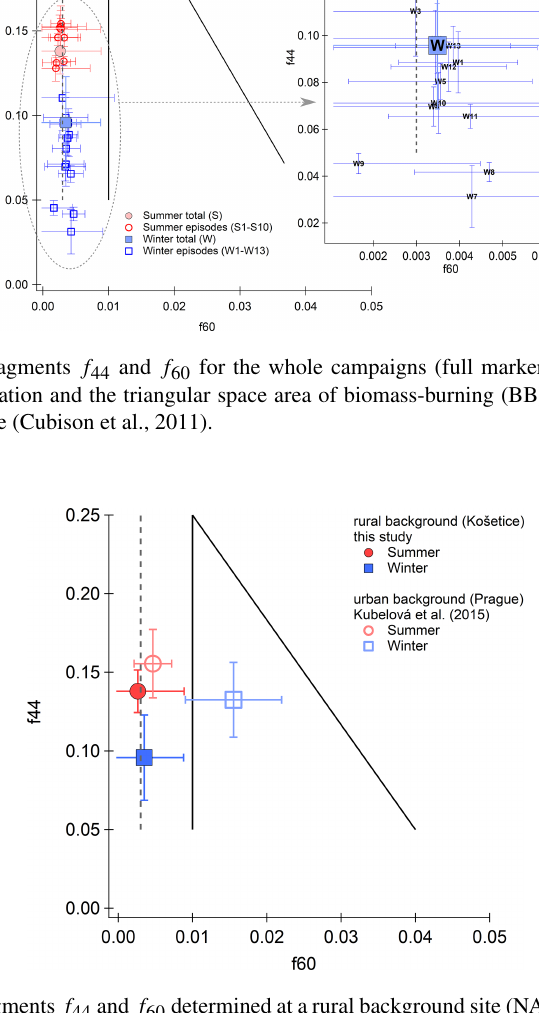
Figure A8. Comparison of organic fragments f 44 and f 60 determined at a rural background site (NAOK) and urban background site (Prague, study by Kubelová et al., 2015) during summer and winter